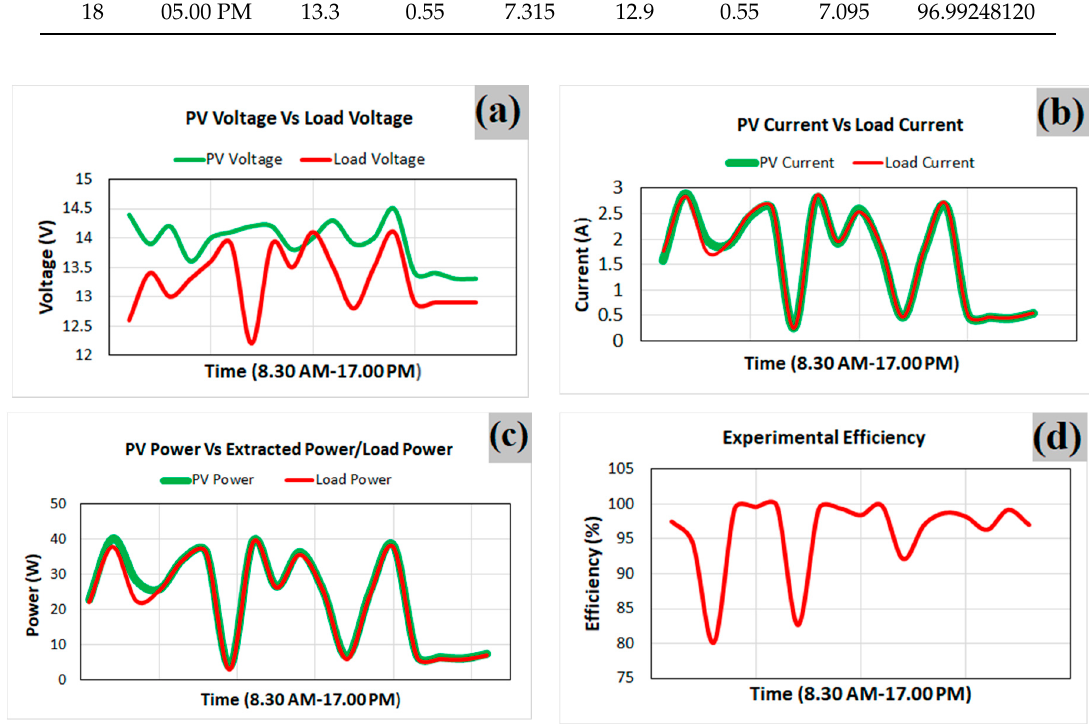
Figure 14. ( a – d ). Graphical representation of experimental results and efficiency.